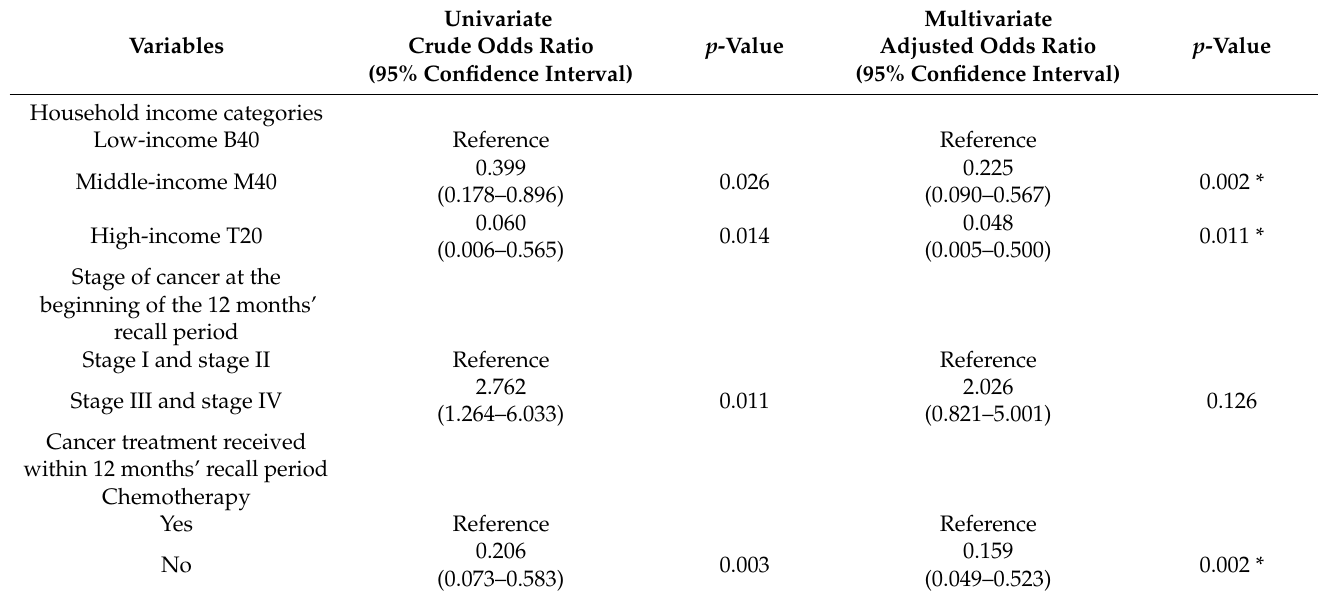
Table 6. Estimated association between variables and catastrophic health expenditure using univari- ate and multivariate regression analysis according to household income categories ( N =